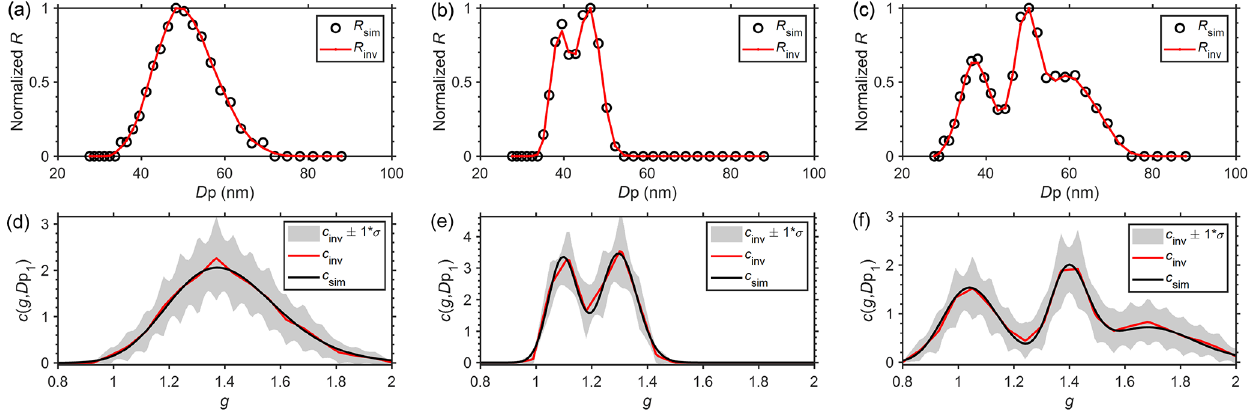
Figure 6. (a–c) Comparisons between the averaged reconstructed HFIMS measurements and the simulated HFIMS measurements corrupted with Poisson noises for pre-defined GF-PDFs of one mode (a) , two modes (b) , and three modes (c), respectively. (d–f) Comparisons between the pre-defined GF-PDFs and the GF-PDFs inverted using Twomey’s method with the optimized value of GF bins. The shaded area represents GF-PDF solution spaces within 1 standard